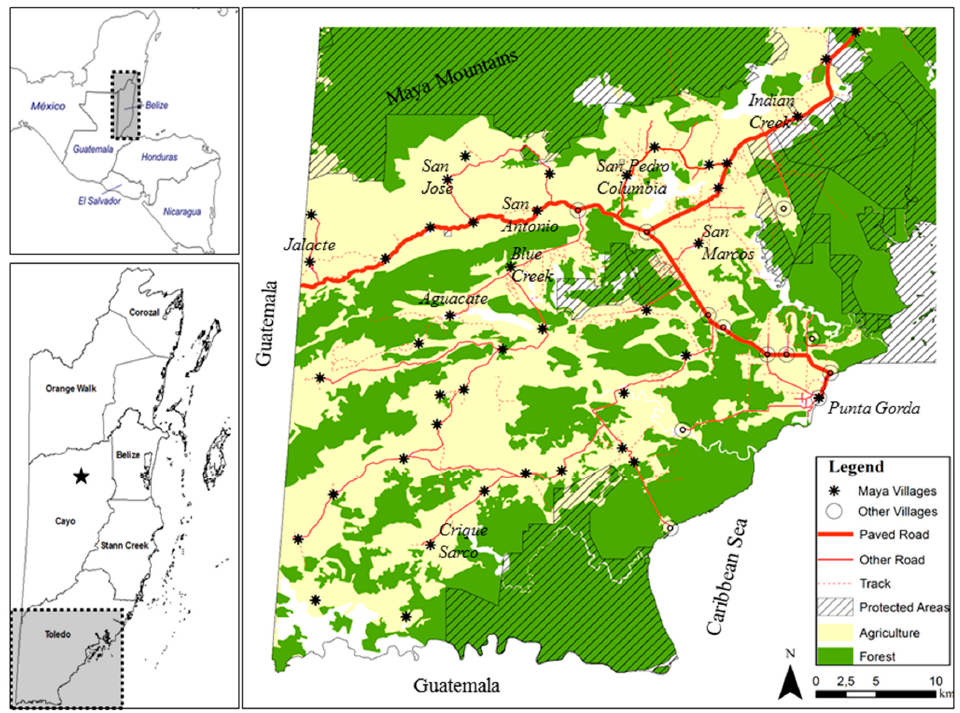
Figure 1. Regional map ( upper left ), Belize with districts ( lower left ) and Toledo District with villages ( right ).